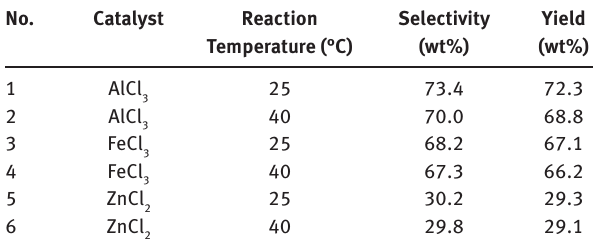
Table 1: The relationship between different catalysts and the results of the acylation reaction of